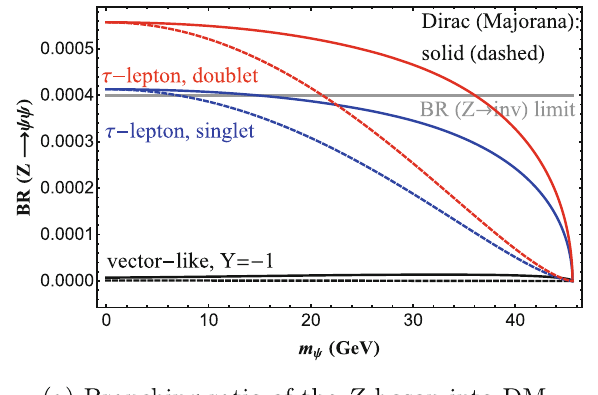
doublet and in blue the case of tau-lepton singlet. The experimental upper limits on non-SM invisible decays are displayed as horizontal gray lines. See the text for